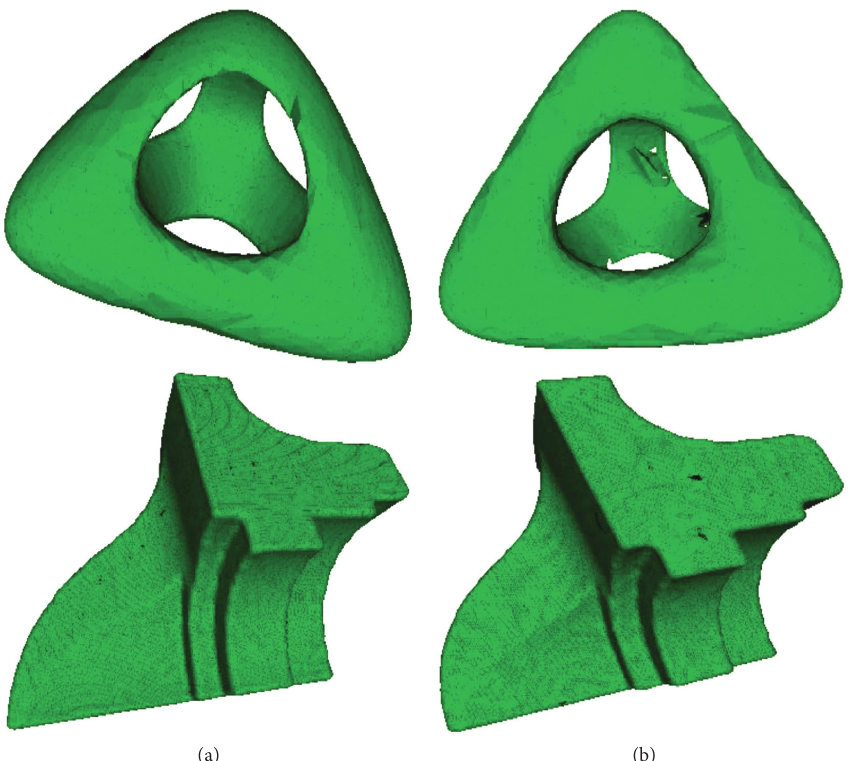
Figure 6: Fandisk and Genus model simplified using the novel method. (a) The original point sets (triangulated). (b) The simplified point cloud sets